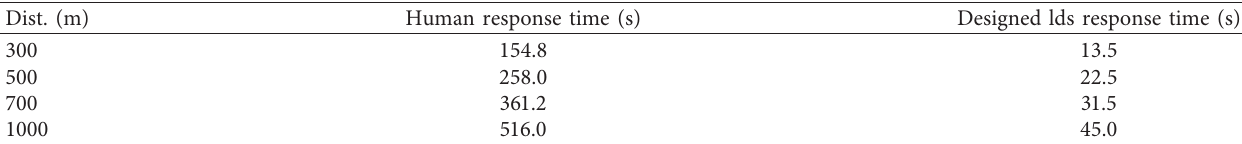
Table 3: Comparison of human response time and designed LDS response